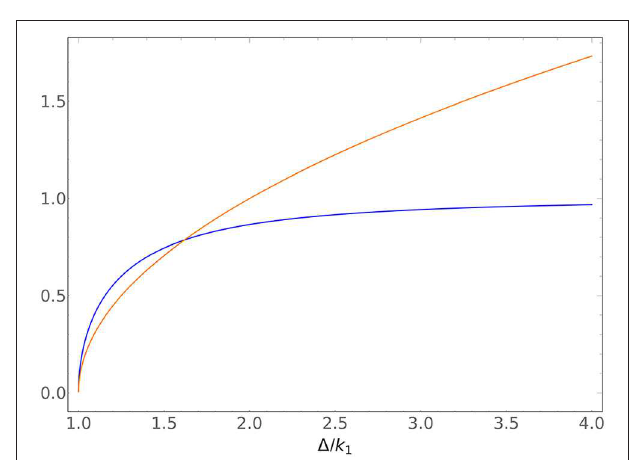
FIGURE 4 | Plot of the cross-over behavior in the k dependence of the inelastic cross-section for a Klein-Gordon particle conversion in units of 1/ k 1 , m 2 1 m 2 2 and m 2 > m 1 . The full function 1 2 / k 2 1 is plotted 1 where 1 − − = q q 1/ k 1 1 is plotted in orange. − Notice the threshold cutoff at 1/ k 1 1, as well as the approximate overlap p =